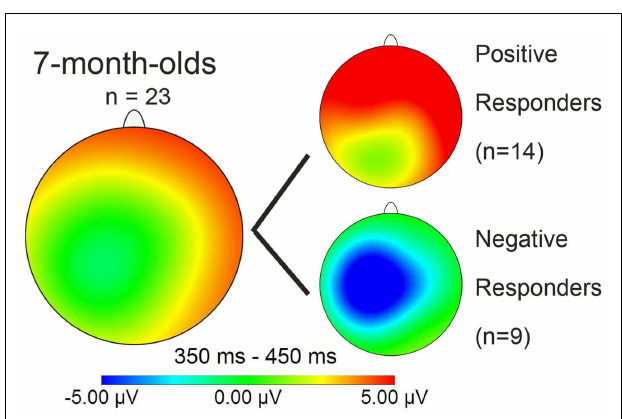
FIGURE 5 | Mean distribution plot for the ERP effect of familiarity (familiarized target – unfamiliar control words) in the 350–450ms time window for those 7-month-olds who returned at 3years for language testing; the two smaller plots divide the 7-month-olds into the sub-groups “Positive responders” and “Negative